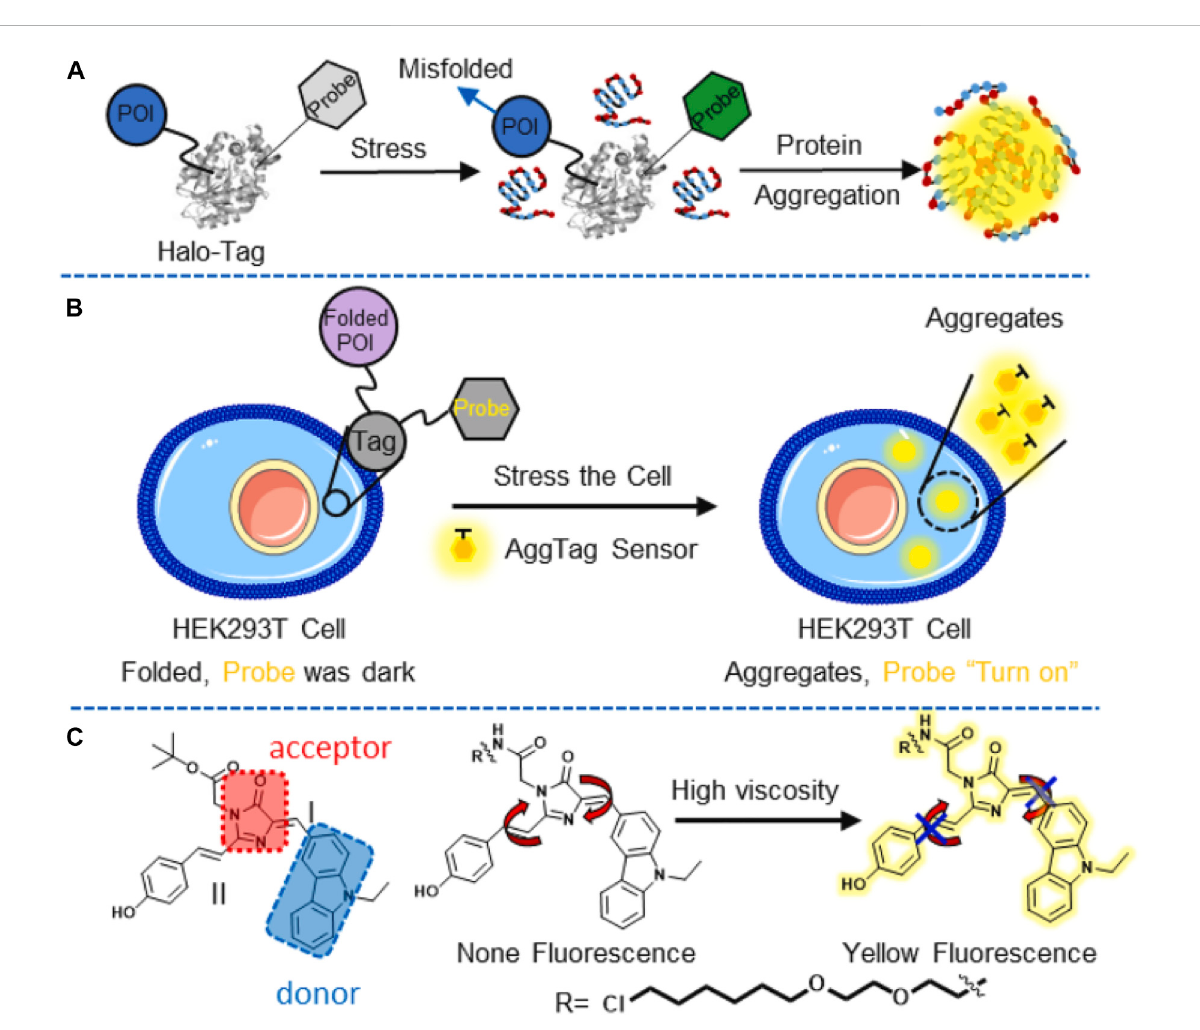
FIGURE 13 (A) IllustrationoftheAgg-Tagmethod;POI:protein-of-interest, Probe:Agg-Fluorprobes; (B) schematicdemonstrationoftheprobedetection of aggregated proteins in HEK293T cells; and (C) fl uorescence of the probe is turned on by rotation restriction at I and II region in highly viscosity microenvironment (Liu et al.,